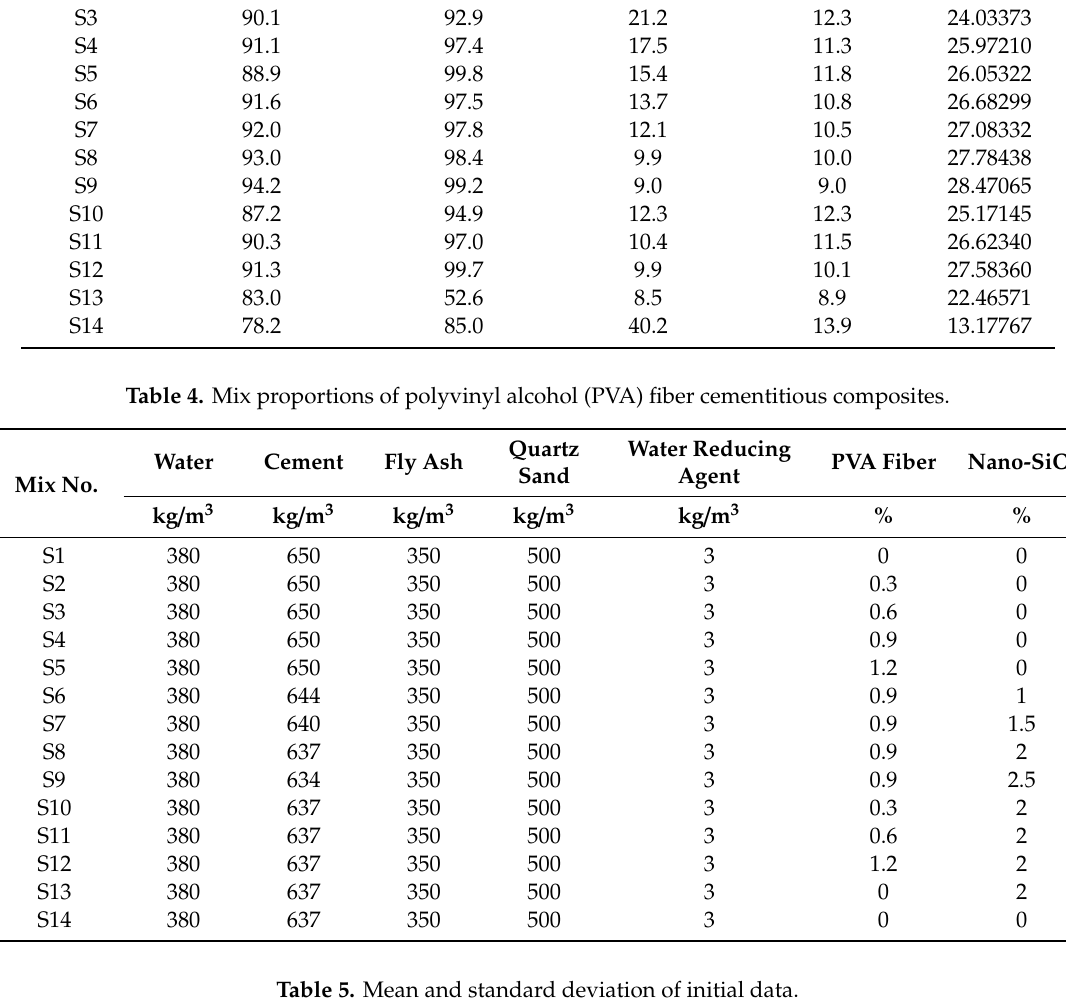
Table 3. Initial data.